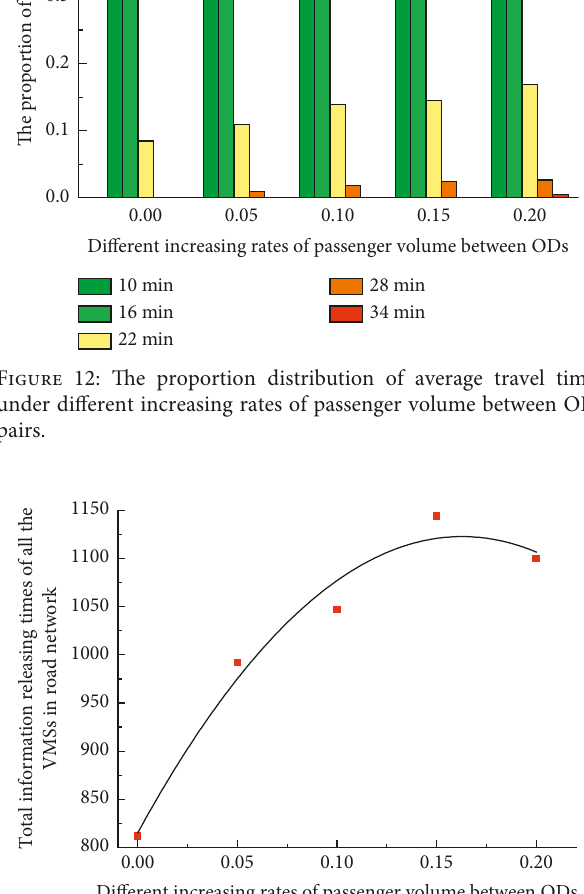
Figure 13: The total information releasing times of all the VMSs in road network under different increasing rates of passenger volume between OD pairs.